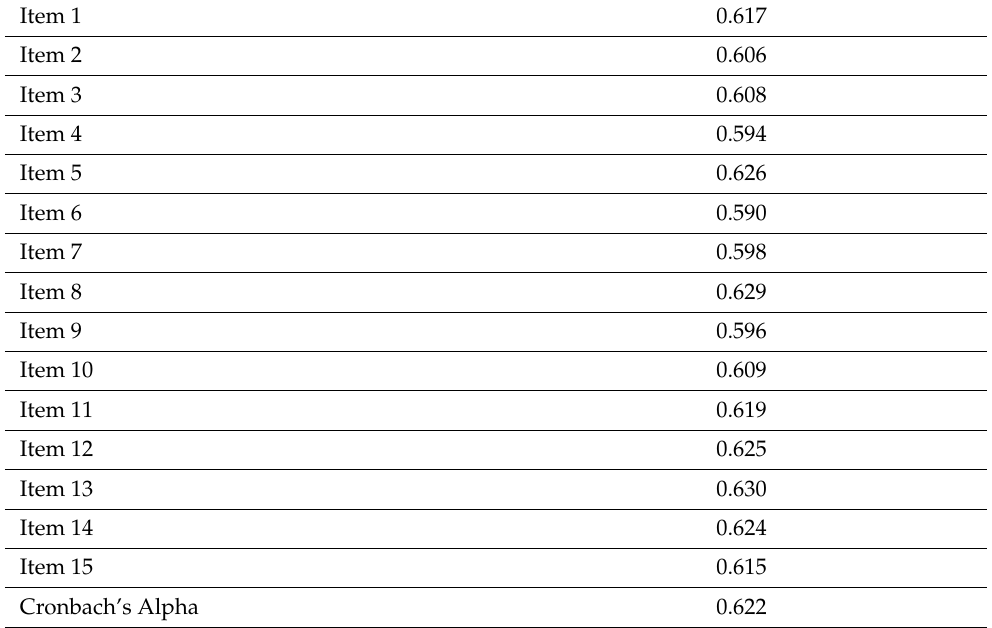
Table 1. Reliability statistics of the questionnaire applied.